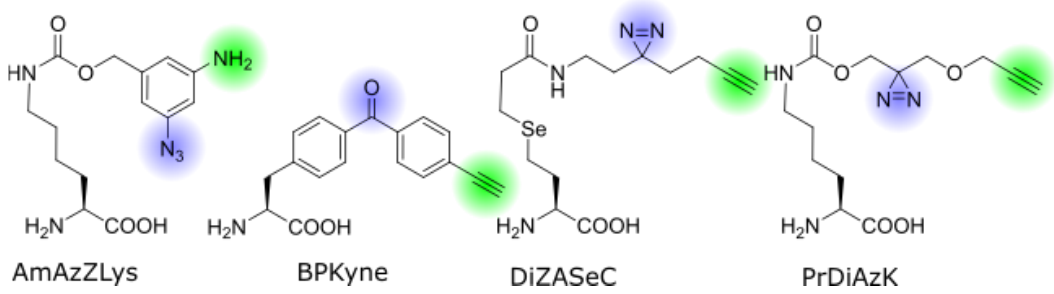
Figure 2. Structures of bifunctional ncAAs discussed in this review. The photo-crosslinker groups and pulldown-handles are highlighted in blue and green, respectively. Table 1. Comparison and properties of four different bifunctional ncAAs.